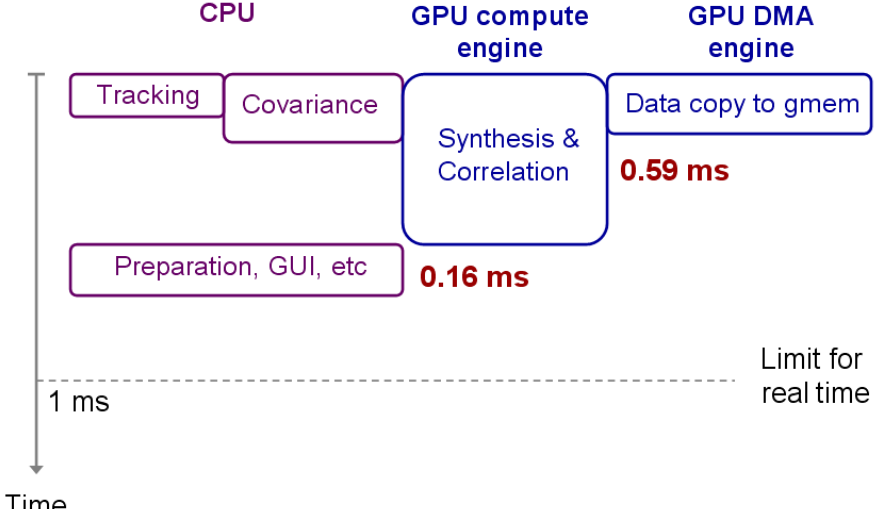
Figure 8. Hardware parallelism with CPU, GPU compute engine, and GPU DMA engine in addition to thread-level parallelism by multi-core CPU and GPU. Total processing time for 1 ms data is about 0.75